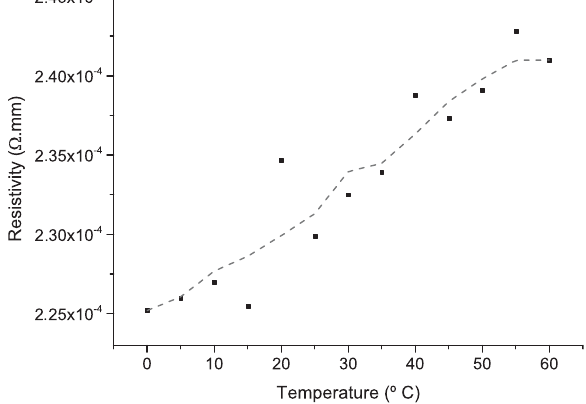
Figure 8. RTD’s resistivity vs. temperature. The dashed line results from a processing data five-point adjacent-averaging smoothing method, which replaces a point using the average of its five closest